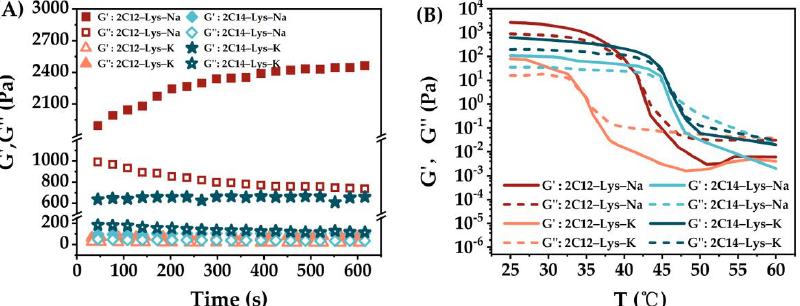
Figure 8. Rheological behaviors of gels formed by 2C12-Lys-Na, 2C12-Lys-K, 2C14-Lys-Na, and 2C14-Lys-K in ethanol – water mixtures: ( A ) Variation of storage modulus (G’) and loss modulus (G″ ) with time; ( B ) dependence of the storage modulus (G’) and loss modulus (G″ ) with the temperature.